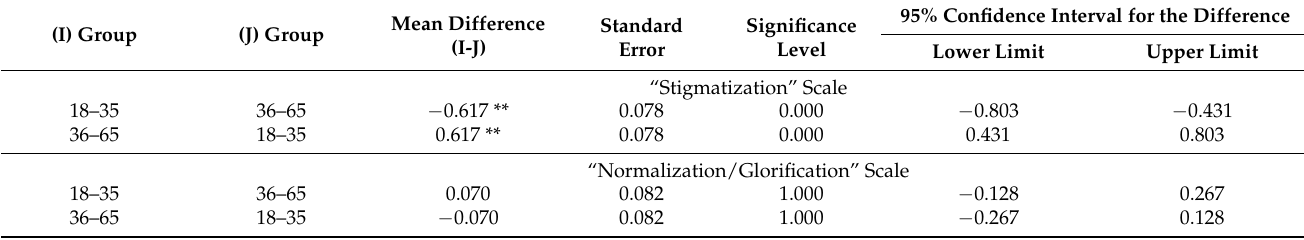
Table 5. Results of the pairwise comparisons according to the Bonferroni test of the two age groups (post hoc of the MANCOVA) regarding the sum scores for the scales “stigmatization” and “normalization/glorification” of the